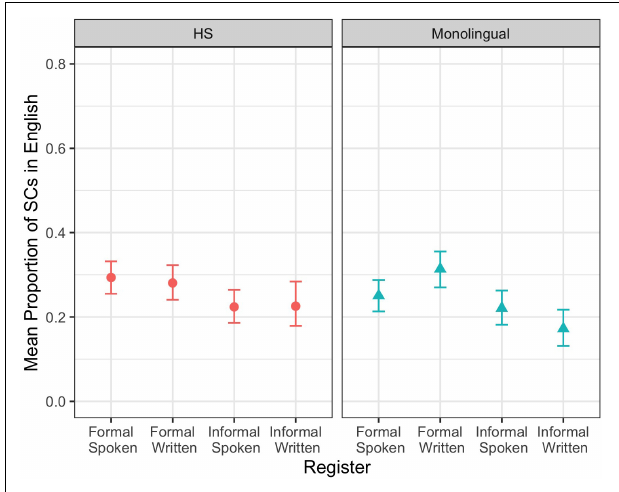
FIGURE 1 | Mean proportion of SCs in English by speaker group and register.